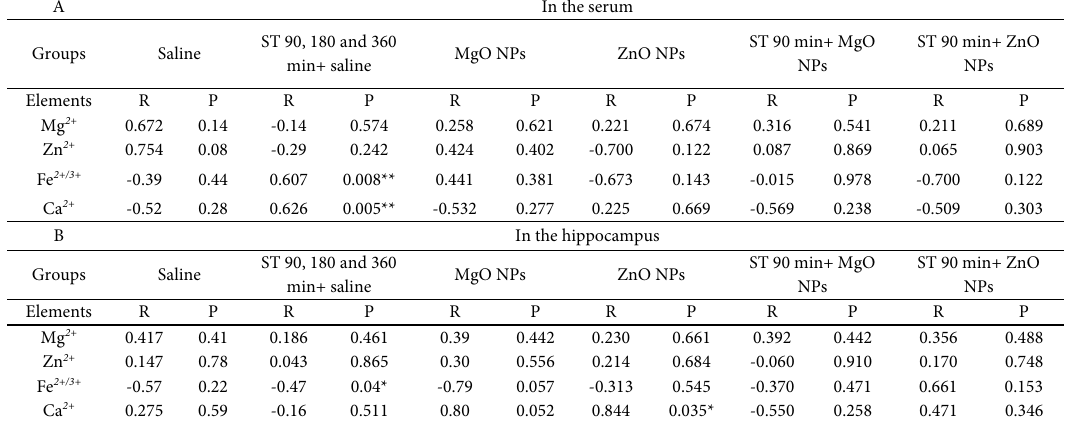
Table 1. Pearson correlation between elements contents at the two times